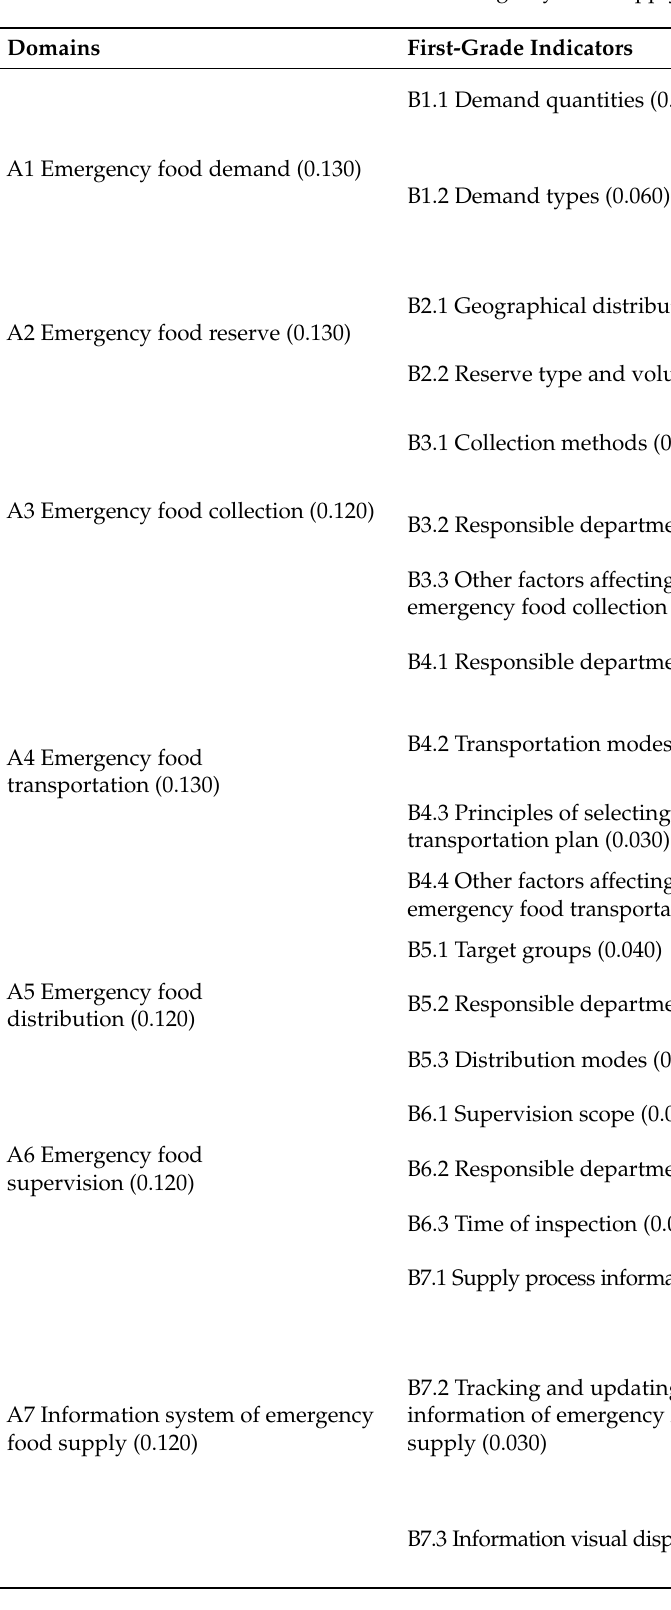
Table 2. The emergency food supply system framework and